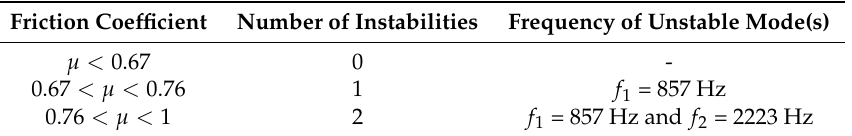
Table 2. Stability analysis of the system versus the friction